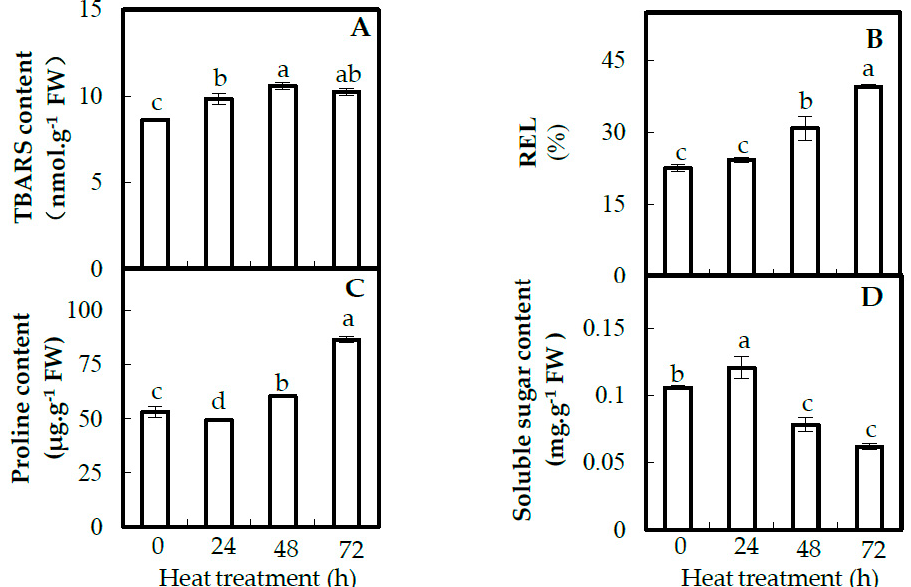
Figure 3. Membrane integrity and osmolyte accumulation in leaves of spinach Sp73 under heat stress. ( A ) Thiobarbituric acid reactive substance (TBARS) content in leaves; ( B ) relative electrolyte leakage (REL) of leaves; ( C ) proline in leaves; ( D ) soluble sugar content in leaves. The values were determined after plants were treated with heat stress at 37 °C /32 °C (day/night) for 0 h, 24 h, 48 h and 72 h and are presented as means ± SD ( n = 3). The different small letters (a–d) indicate significant di ff erence ( p < 0.05) among di ff erent